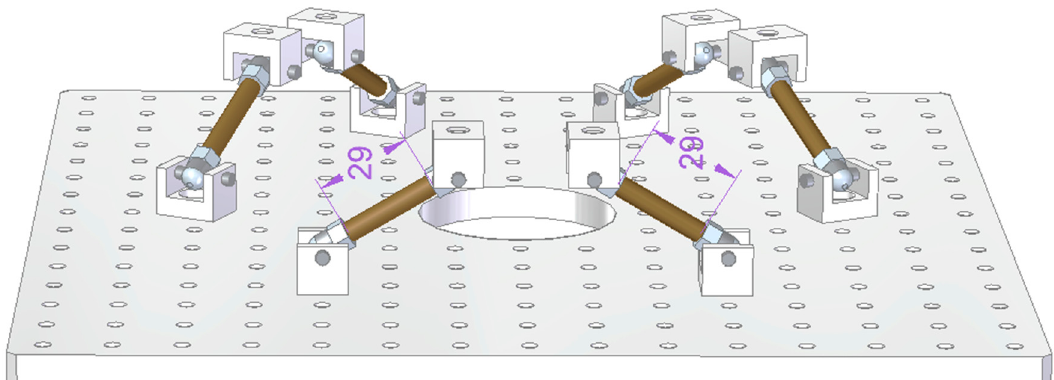
Figure 3. Schematic of the connecting rods.